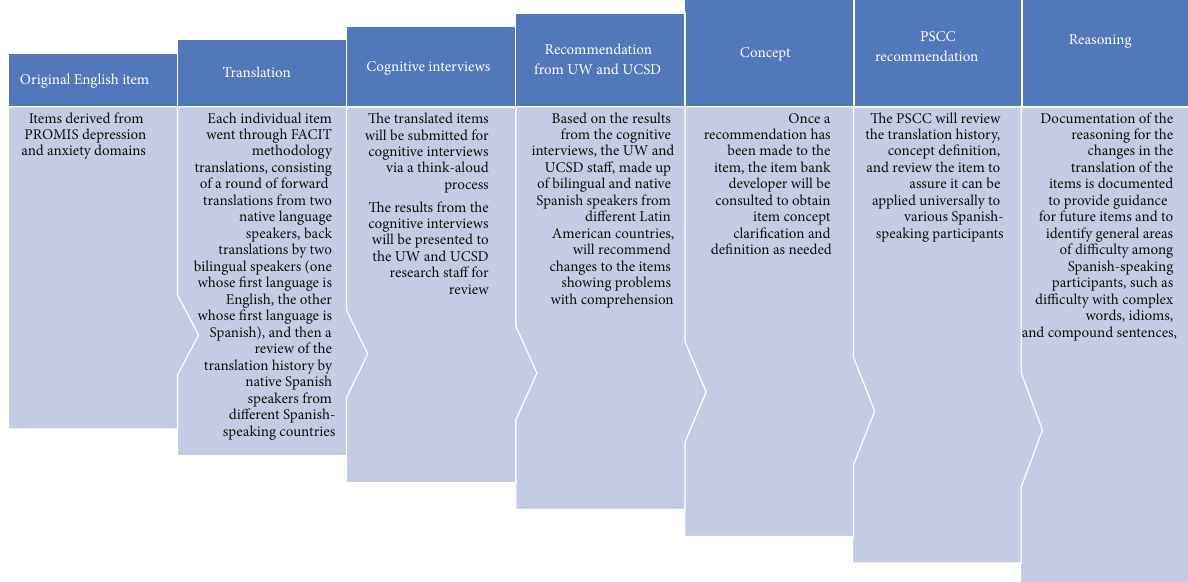
Figure 1: Flow diagram demonstrating the use of cognitive interview results on comprehension among Spanish-speaking participants.